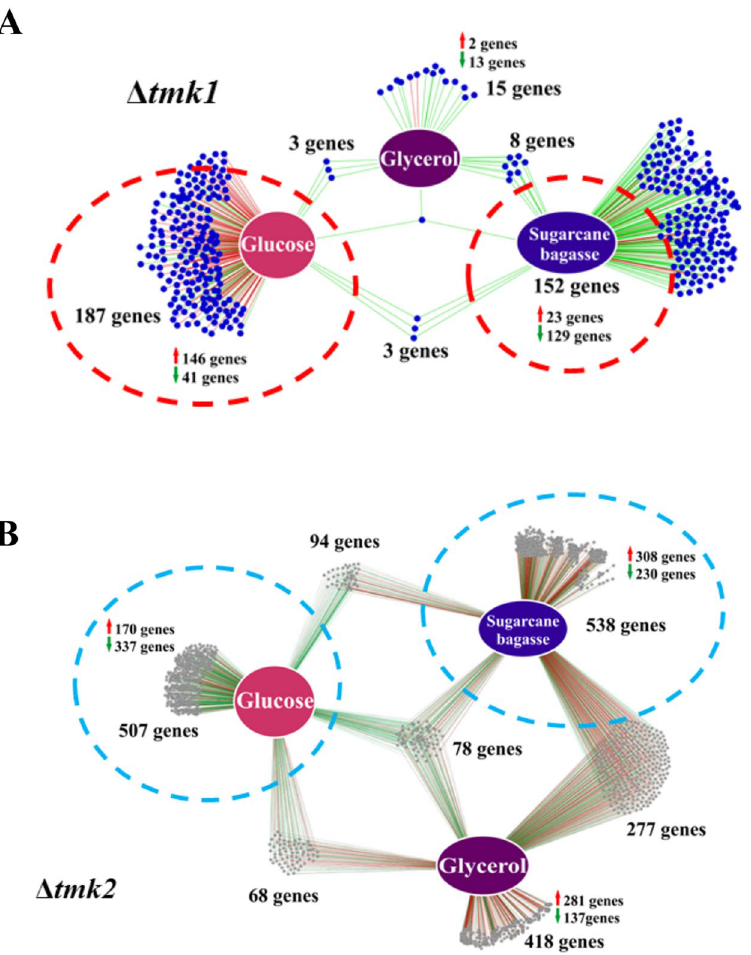
Figure 2. Gene Regulatory Network (GRN) of differentially expressed genes in the mutant strains grown in glucose, sugarcane, and glycerol. ( A ) GRN of 402 differentially expressed genes in the Δ tmk1 compared to the QM6a ( Δ tmk1/ QM6a) in the presence of glucose, glycerol, and sugarcane bagasse. Genes are represented as nodes (circles), and interactions are represented as edges (red lines: upregulated interactions, green lines: downregulated interactions), connecting the nodes: 382 interactions, ( B ) GRN of 2575 differentially expressed genes in the Δ tmk2 compared to the QM6a ( Δ tmk2/ QM6a) in the presence of glucose, glycerol, and sugarcane bagasse. Genes are represented as nodes (shown as circles), and interactions are represented as edges (red lines: upregulated interactions, green lines: downregulated interactions), connecting the nodes: 1980